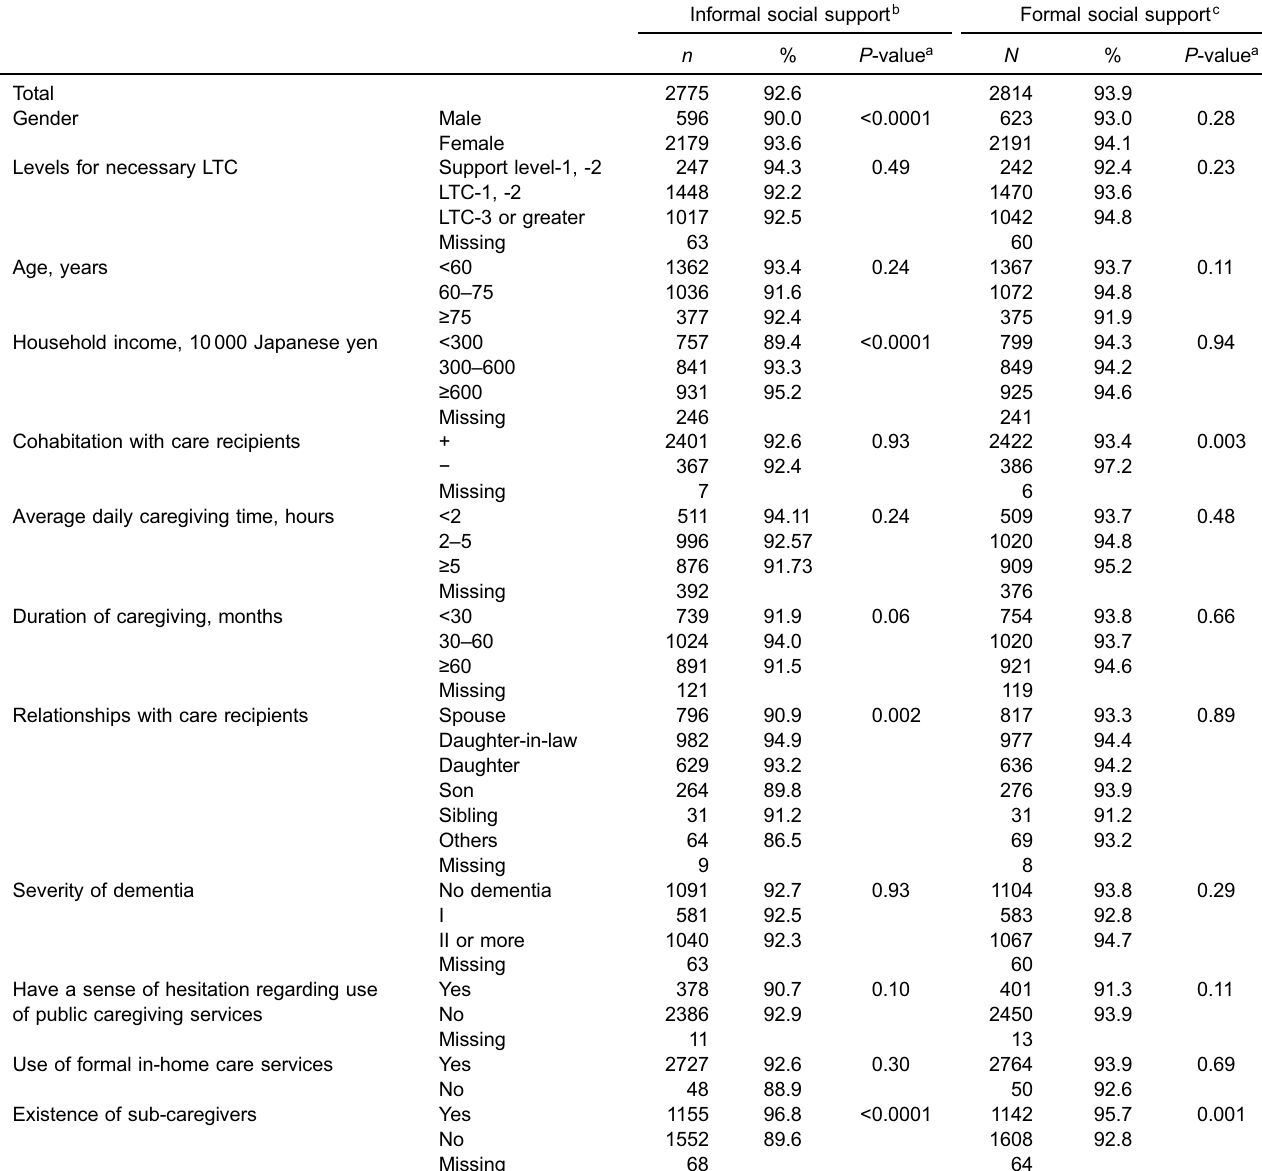
Informal social support